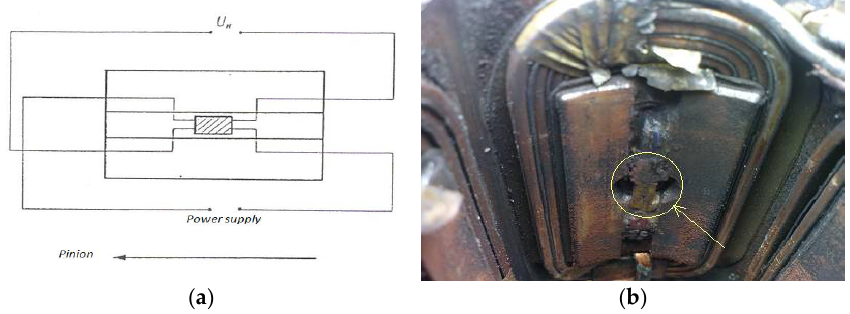
Figure 6. Connections of the Hall sensor placed on the pole shoe ( a ) and the Hall sensor placed on the pole shoe in the starter ( b ).